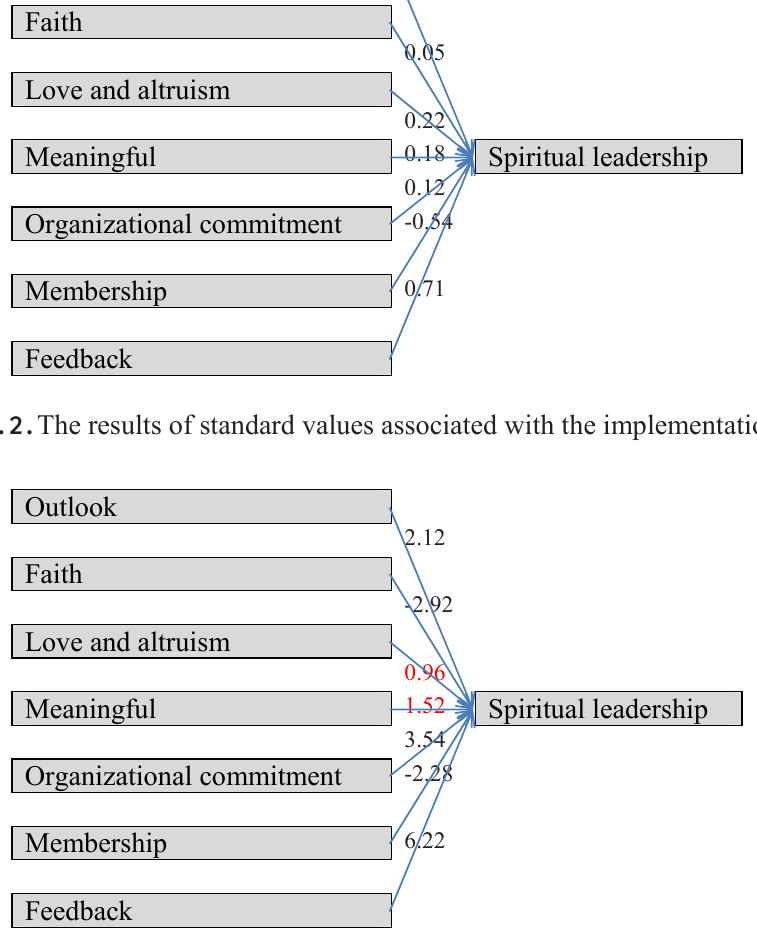
Fig. 3. The results of t-student values associated with the implementation of SEM